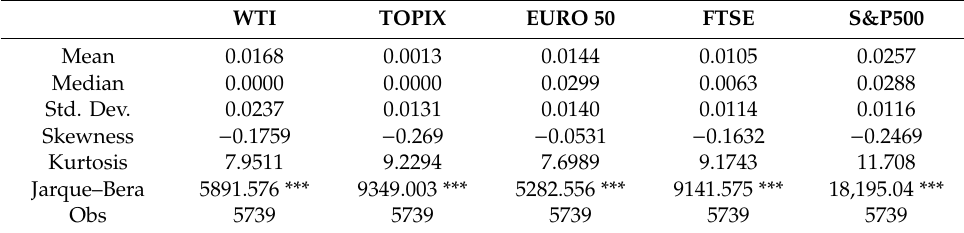
Table 1. Summary statistics for returns on oil and stock prices. WTI: West Texas Intermediate.